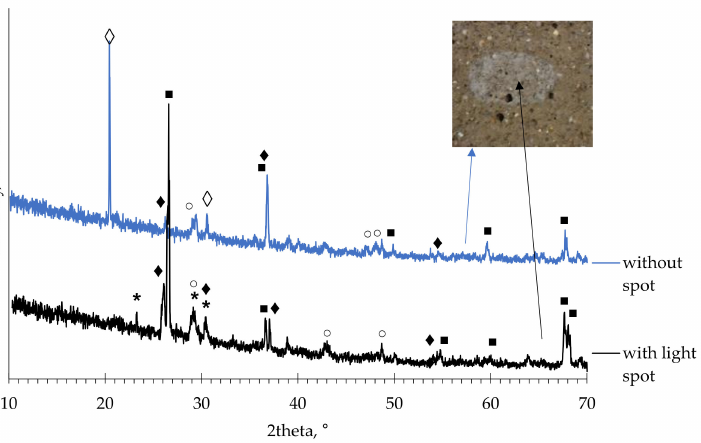
Figure 16. XRD pattern of split sample with 0% CFA ( (cid:4) —quartz; ♦ —Ca (cid:7) —Ca · 12H × 12H 2 Al 4 Si 8 O 24 2 O; 4 Fe 2 S 2 O 9 2